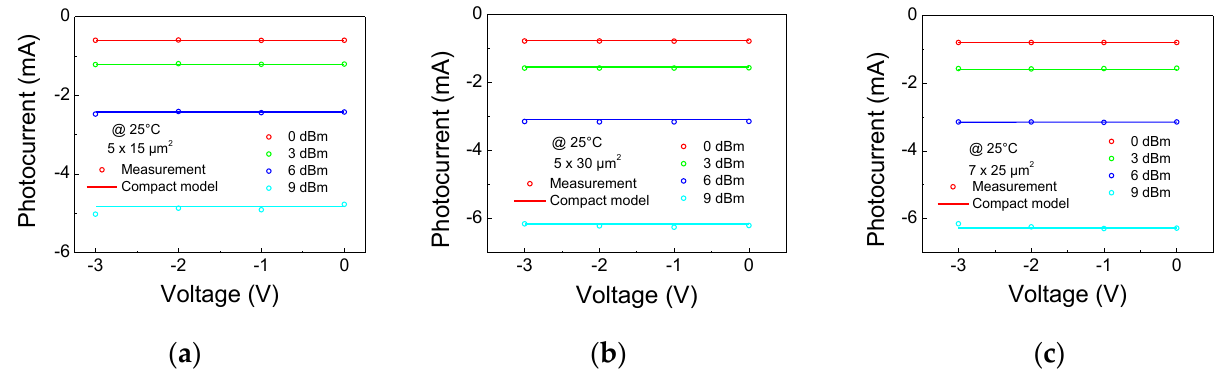
Figure 7. Measured (symbol) and simulated (line) photocurrent of UTC-PD with an active area of ( a ) 5 × 15 µm 2 ( b ) 5 × 30 µm 2 ( c ) 7 × 25 µm 2 .